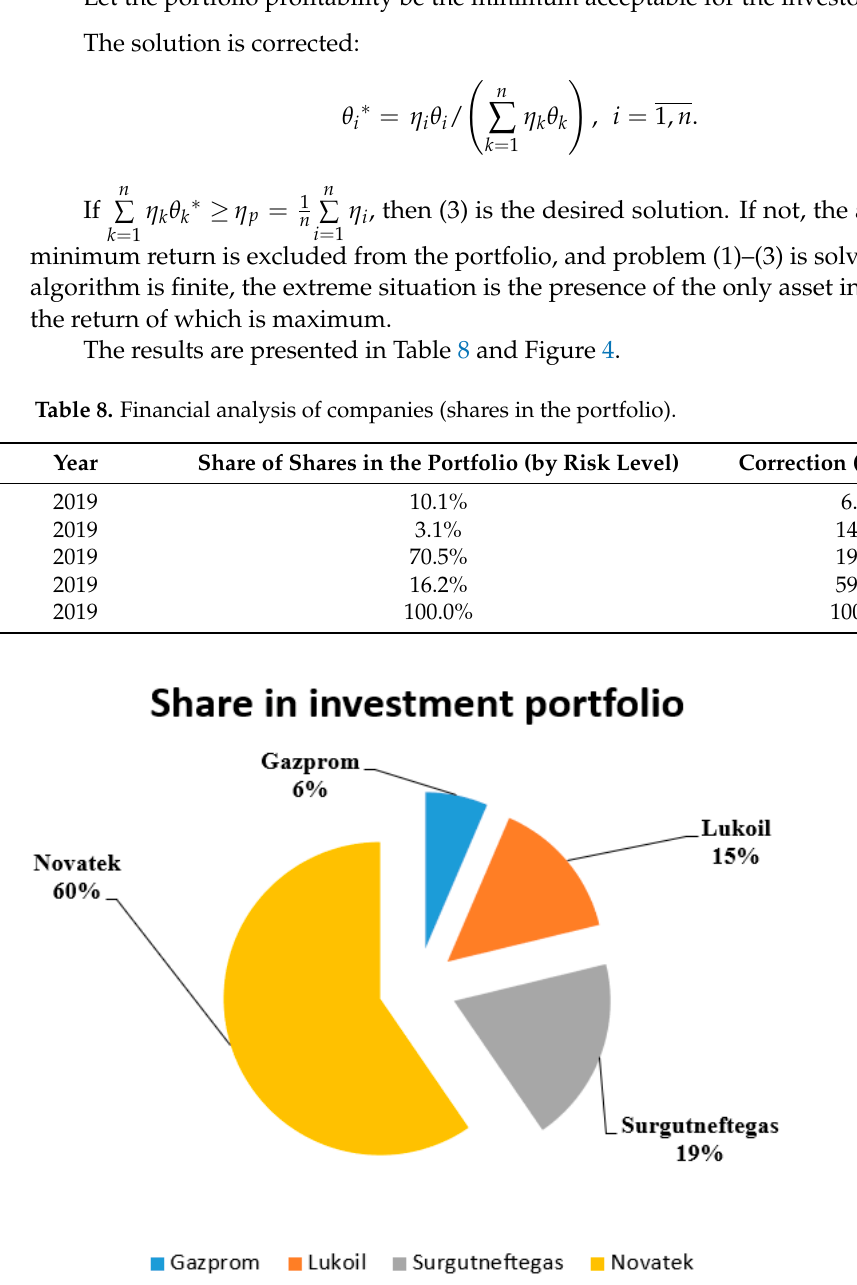
Figure 4. Shares of companies’ shares in the investor’s portfolio.